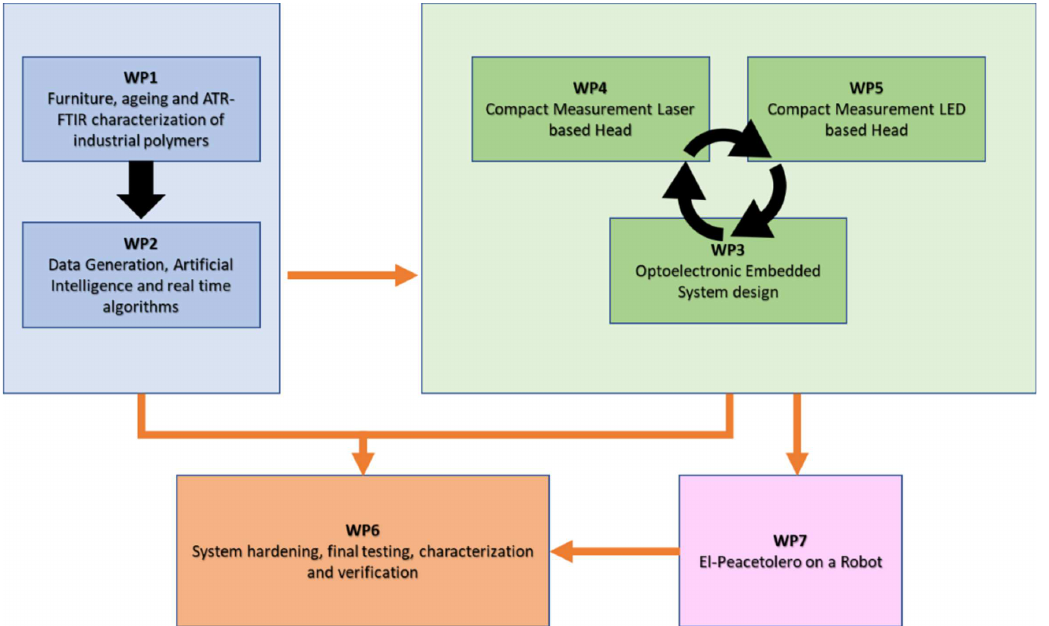
Fig. 3. El-Peacetolero work